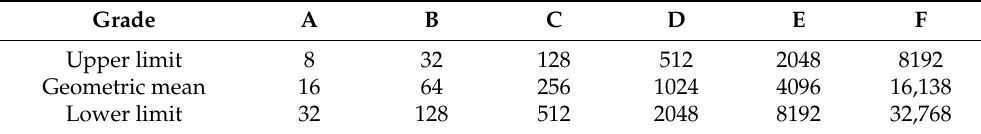
Table 1. Classification of pavement grades based on G q ( n ) .